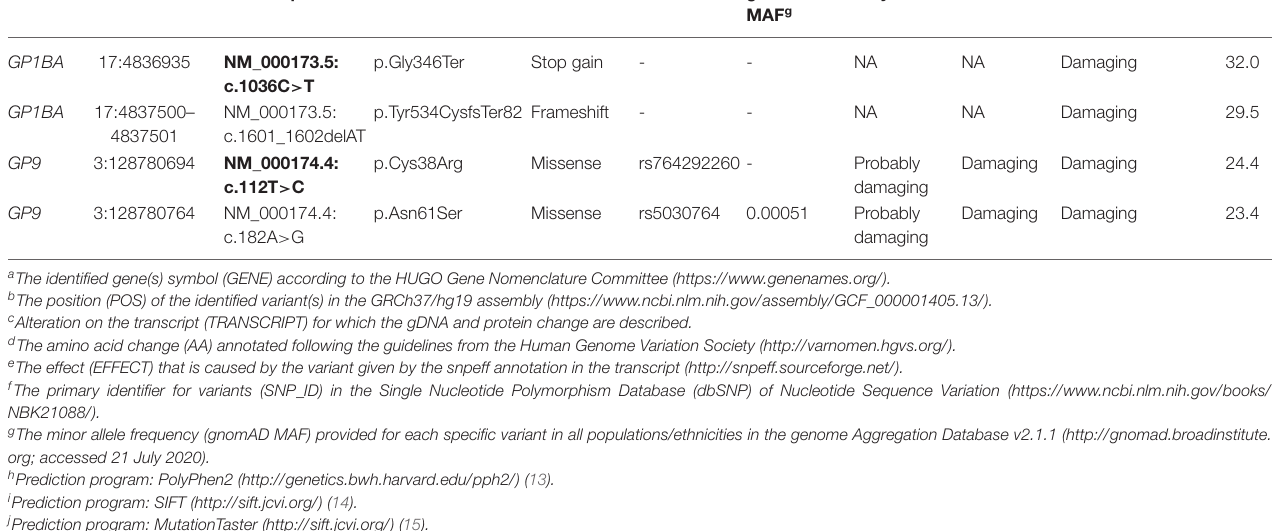
TABLE 2 | Results of the molecular genetic testing. GENE a POS